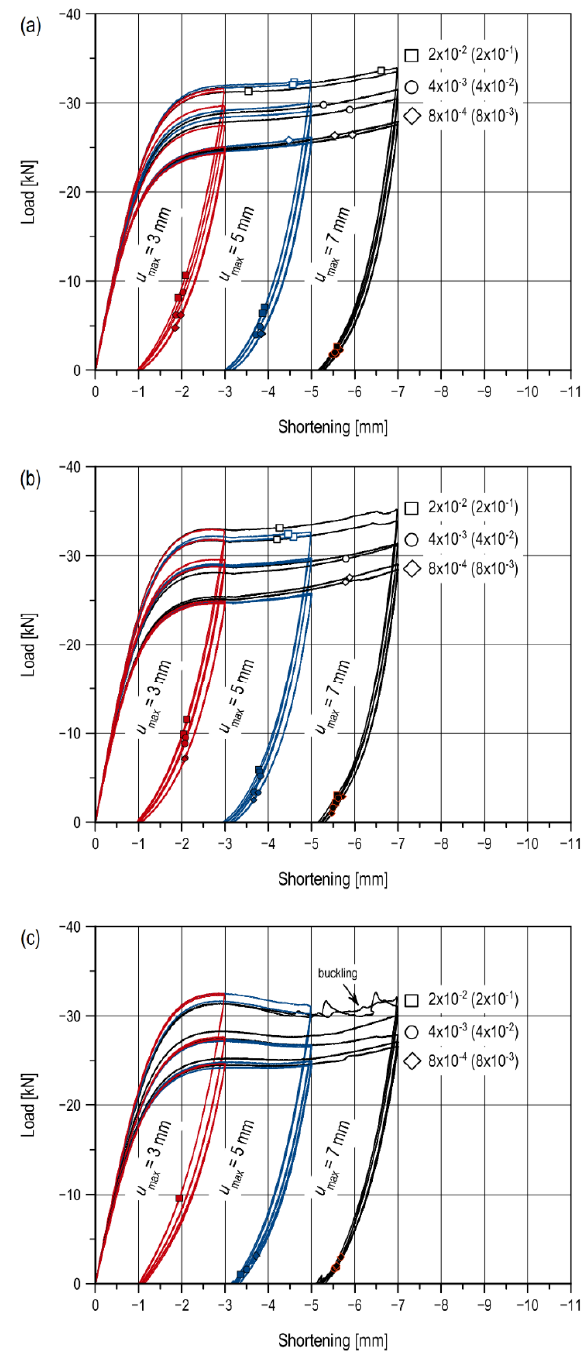
Figure 4. Compression curves with fracture initiation points for V-notched specimens with ( a ) root ≈ 0 mm; ( b ) root radius R ≈ 1 mm; and ( c ) for U-notched specimens ( t radius R ≈ 0 mm; ( b ) root radius R ≈ 1 mm; and ( c ) for U-notched specimens ( t 1 = 9.7 mm). radius R